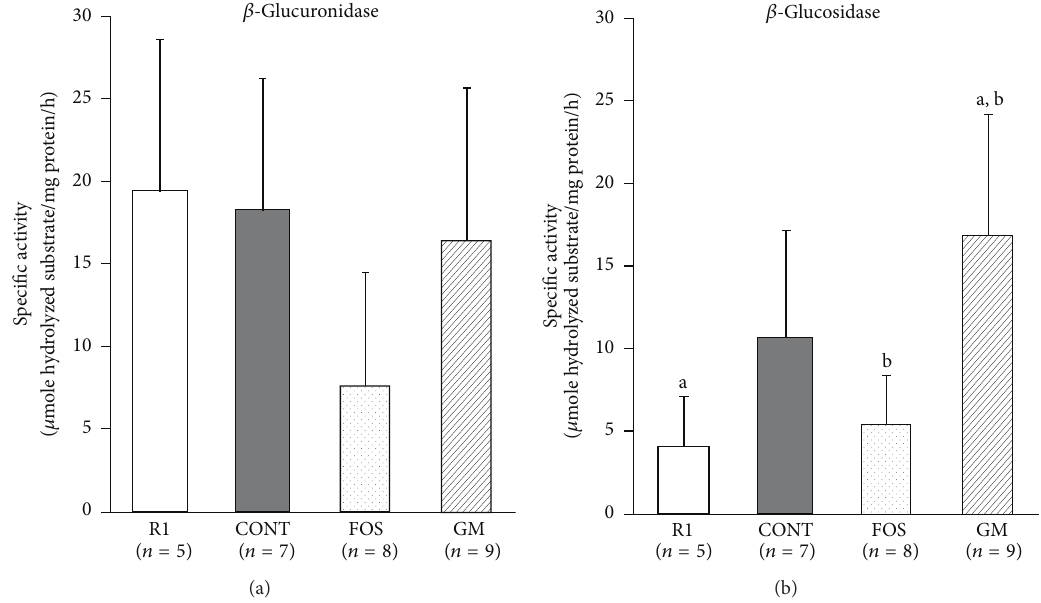
Figure 4: Effects of FOS or GM feeding on microbial enzyme activities in feces at 38 weeks after feeding. Values were expressed as mean ± SD. R1, SAMR1, and control diet; CONT, control diet; FOS, 5% of fructooligosaccharide; GM, 5% of glucomannan. a, b: significant differences were evaluated by one-way ANOVA and same superscripts were significantly different by Tukey’s post hoc test, at 𝑃 < 0.05